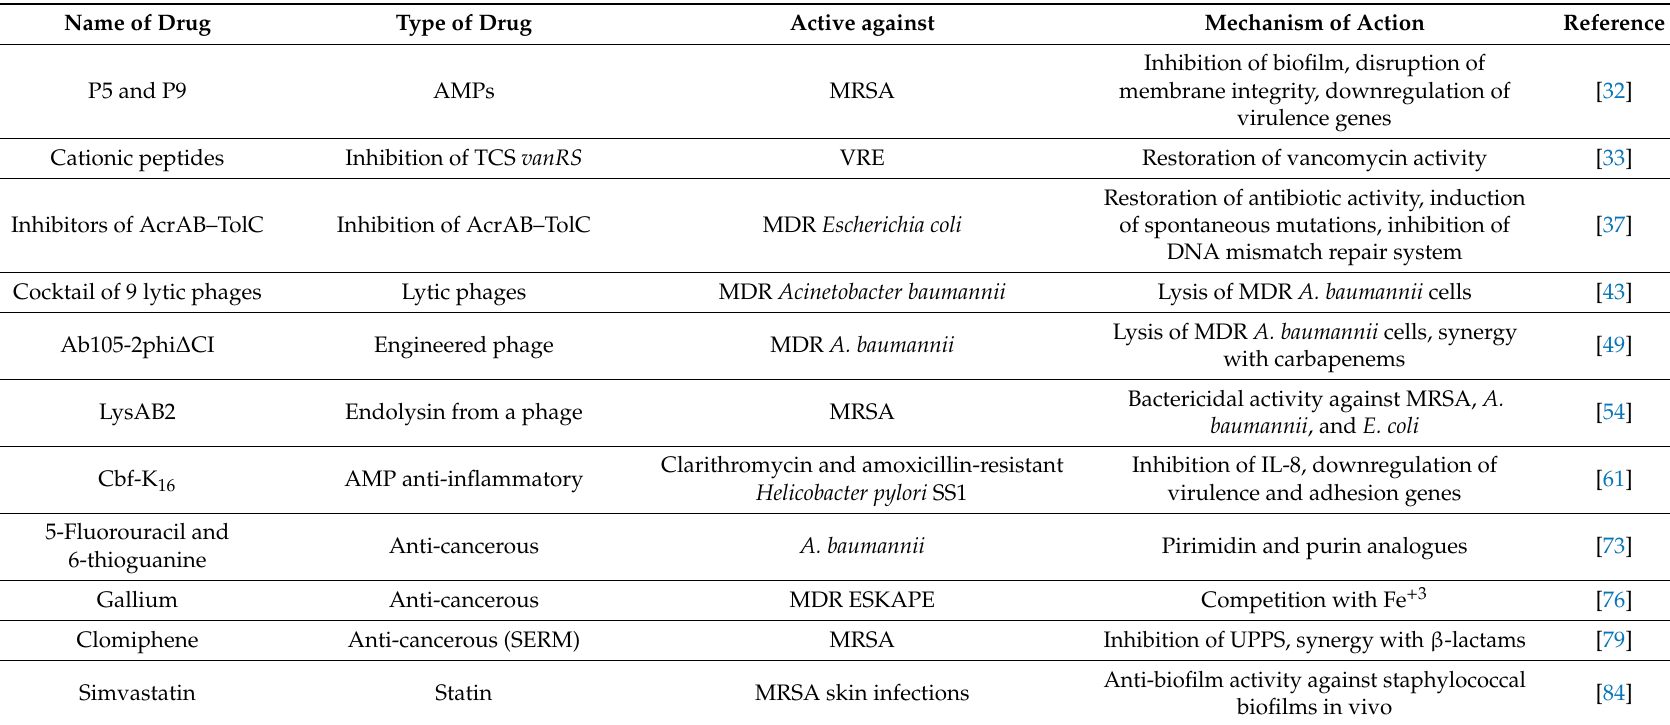
Table 1. Anti-multidrug-resistance (MDR) molecules that show activity against multidrug-resistant